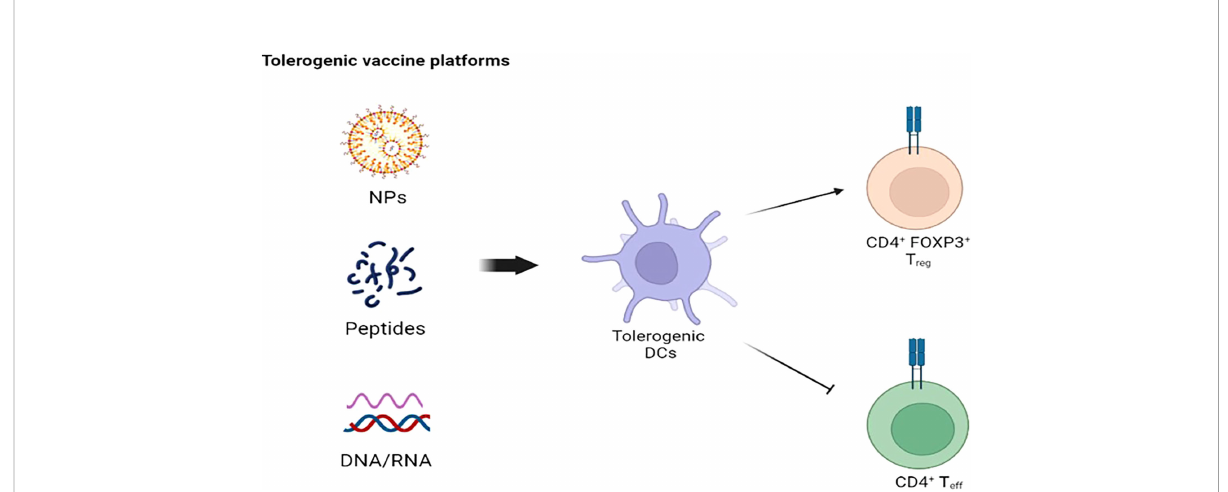
FIGURE 3 Tolerogenic vaccine platforms: The goal of NPs-, peptides-, and DNA/RNA-based platformes is to stimulate tolerogenic DCs to suppress CD4 + T cell-mediated autoimmunity. NPS, nanoparticles; DC, dendritic